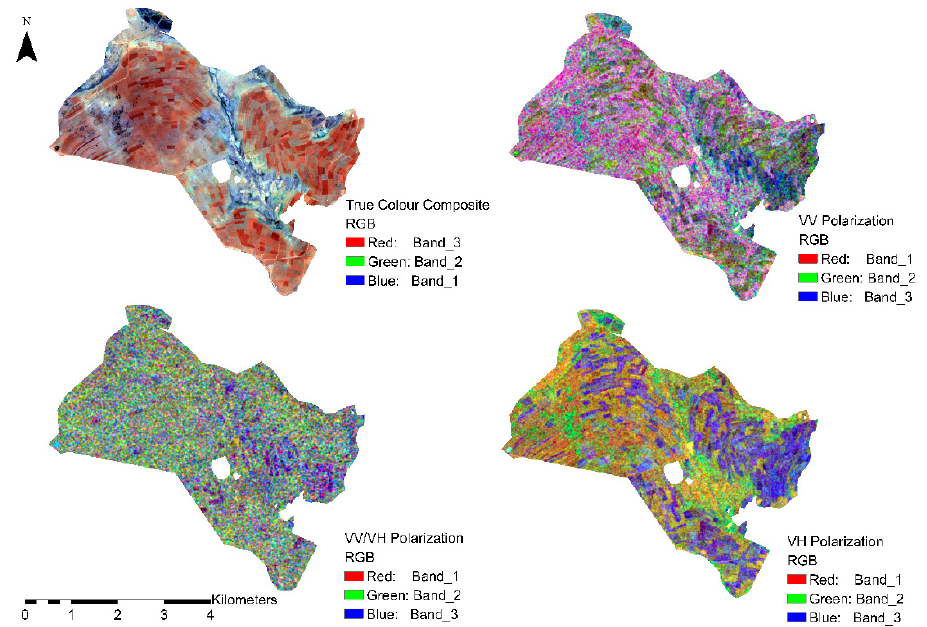
Figure 6. Examples of the PCA images for different polarizations derived from Sentinel-1 datasets. The PCA VH polarization composite seems to visually enhance smallholder farms compared to other polarizations.